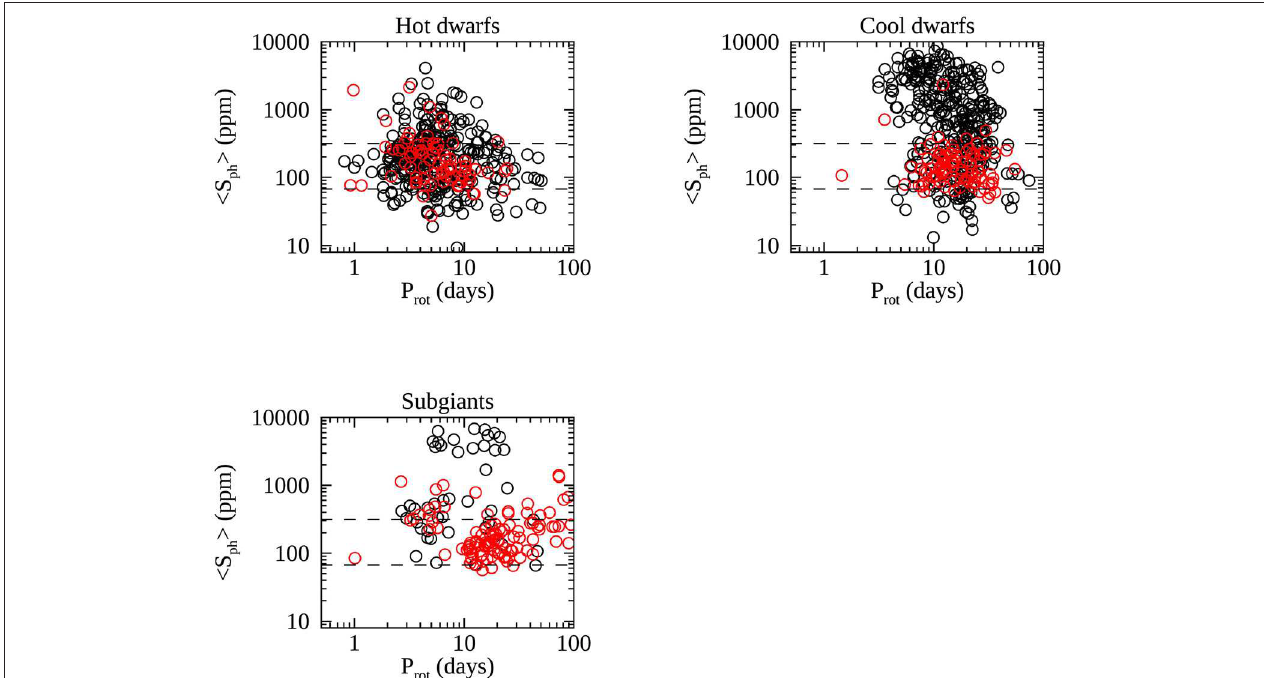
FIGURE 11 | Same as Figure 9 but separated into the three categories of stars: hot dwarfs, cool dwarfs, and subgiants.